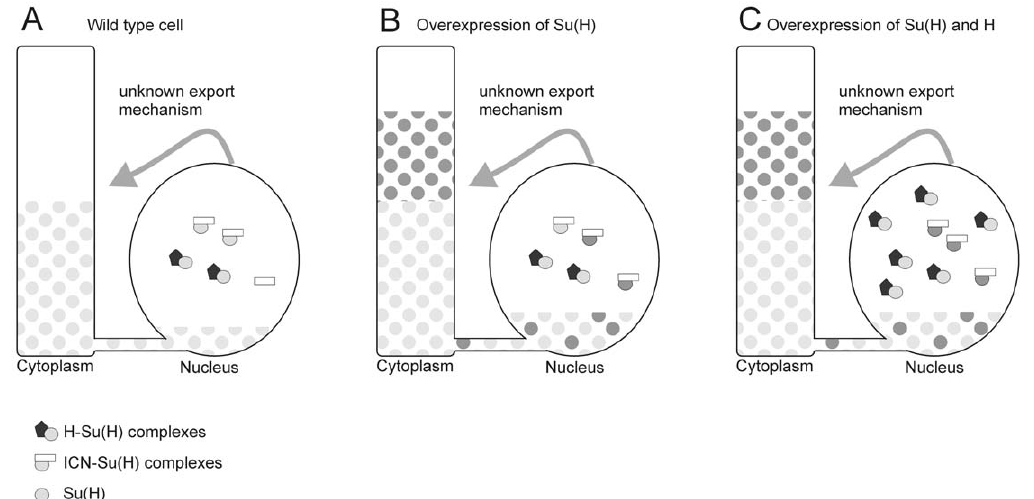
Figure 8. Modell of a Su(H) cytoplasmic pool. A) The large cytoplasmic pool of Su(H) is not available for complex formation in the nucleus, however, is used to replenish nuclear Su(H). This explains the apparent limitation of Su(H) when ICN is overexpressed. The export mechanism is currently unknown and may represent a further level of Su(H) regulation. B) Overexpression of Su(H) increases the cytoplasmic protein pool, thereby raising the level of available nuclear Su(H). This may cause Notch gain of function phenotypes in tissues, where Notch signalling takes place, or in the presence of exogenous ICN. The darker colour represents mutant Su(H) protein to exemplify the model; wild type Su(H) would behave identical. C) Combined overexpression of Su(H) and Hairless allows formation of repressor complex, as long as endogenous wild type Su(H) is available from the cytoplasmic pool. Lack of binding of Hairless to mutant Su(H) predicts an enrichment of activator complexes containing the mutant Su(H) and ICN.